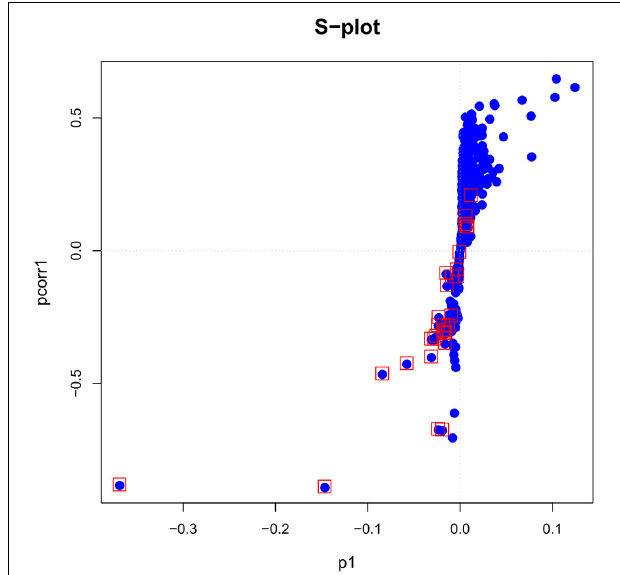
FIGURE 2 | The S-plot based on p -values of correlation and covariance between metabolites in the plasma of patients with papillary thyroid carcinoma patient and healthy control